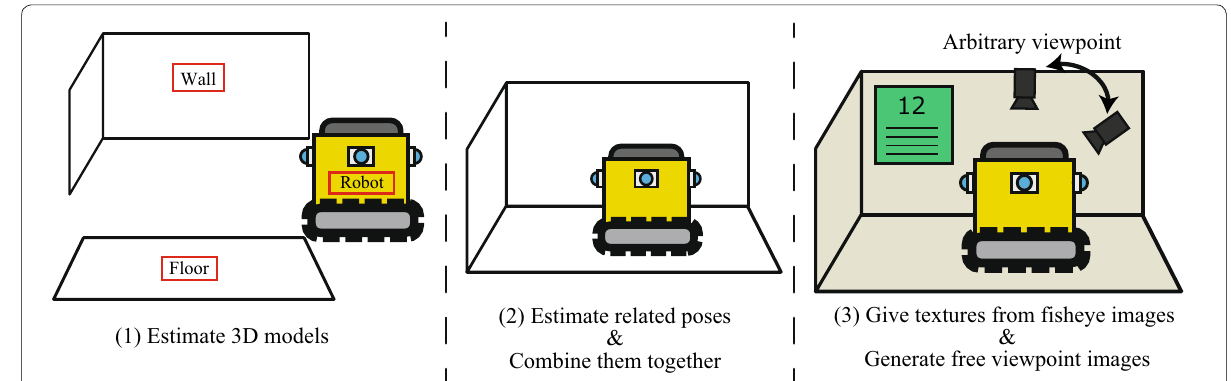
Fig. 3 Overview of the proposed method. From left to right: (1) 3D models of the robot, the floor, and the walls are estimated. Only the robot model has a texture. (2) The relative poses of the robot, the floor, and the walls are estimated and combined. (3) Their textures are obtained from fisheye images, and free viewpoint images are